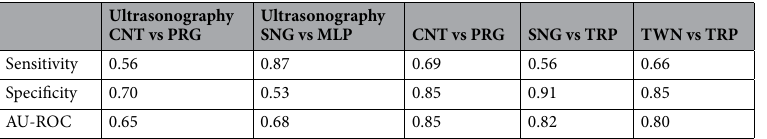
Table 7. Performance comparison of metabolomic biomarkers and ultrasonography. Sensitivity and specificity and the ability to predict sheep PLS is compared between ultrasonography and regression models of blood metabolite biomarkers. Most biomarker panels offer a higher sensitivity and specificity than that of ultrasound diagnosis of PLS. The values calculated for ultrasound are for detecting pregnancy status (CNT vs PRG) and whether the pregnant ewes carry a single fetus or more (SNG vs MLP) while, the biomarker panels also identify the specific number of the litter (i.e., SNG, TWN,